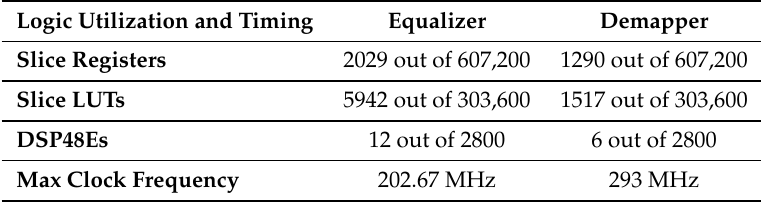
Table 1. FPGA synthesis results of the proposed NISC-based equalizer and demapper architectures targeting Xilinx Virtex-7